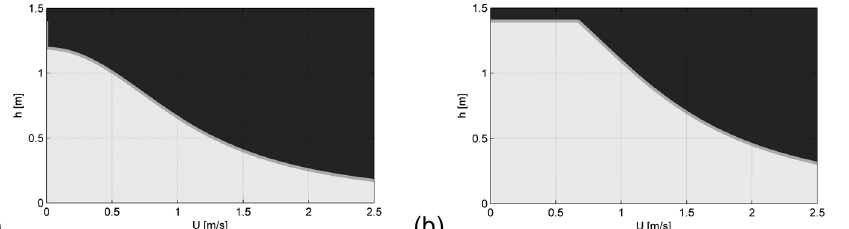
Fig. 4 Hydraulic hazard criterion based on translational equilibrium and drowning limit for an individual run over by a debris flow (a) or by water flow (b); individual mass 71.5 kg and height Y = 1.7 m. Here =